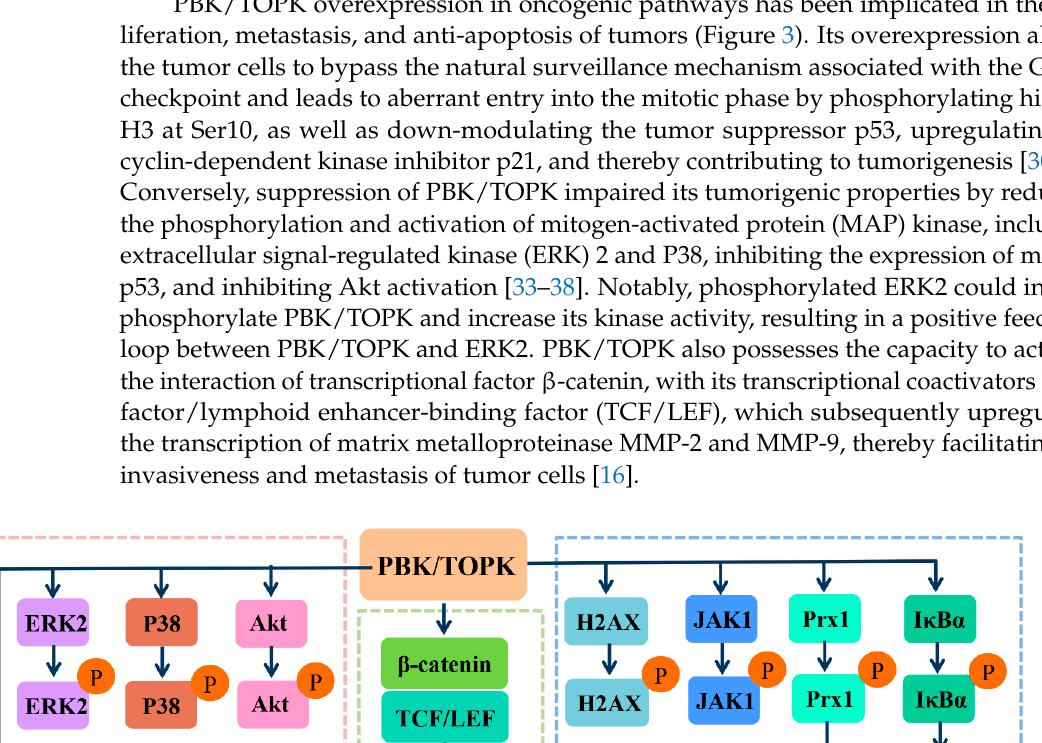
Figure 2. Signaling pathways involved in mitotic progression functions of PBK/TOPK. Abbreviations: PTEN, phosphatase and tensin homolog; Akt, also known as protein kinase B; ZFP, zinc finger proteins; LGN/GPSM2, Leu-Gly-Asn repeat- enriched protein/G-protein signaling modulator 2; PRC1, microtubule binding protein.